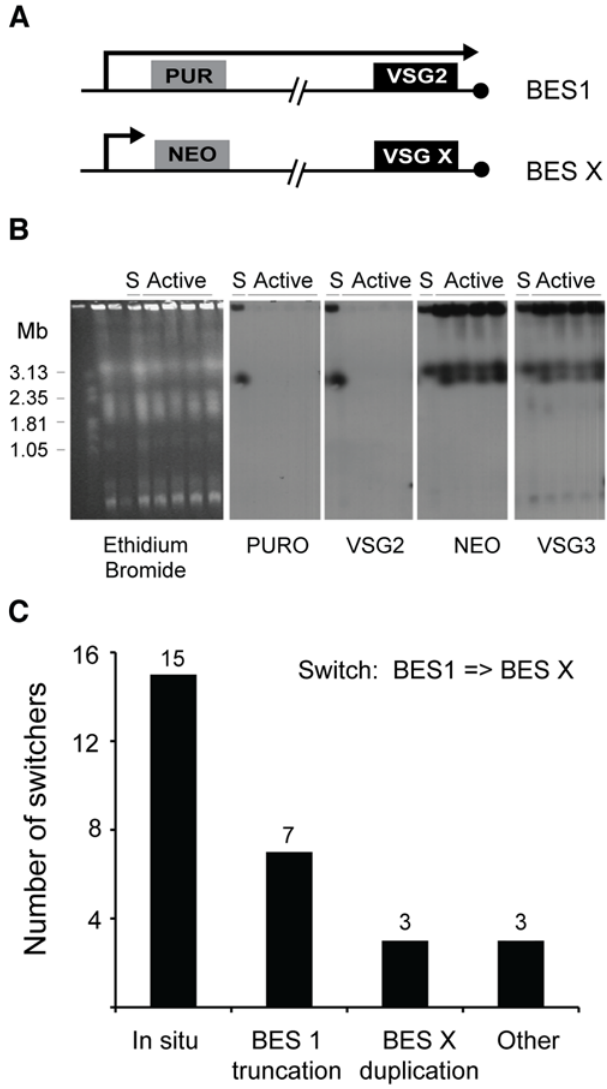
Figure 2. Types of switching mechanisms observed for tagged BES clones invitro . A. NEO -tagged clones have PUR in BES1 and NEO in an unknown BES. B. Example of a BES duplication. PFGE analysis of a BES7-tagged clone (17.9), when this BES is silent (S) and after activation. NEO and VSG3 genes were duplicated onto the chromosome that originally contained PUR and VSG221/427-2 . C. Quantification of the frequency of the different types of mechanisms. ‘‘Other’’ refers to recombination events that involved more than 2